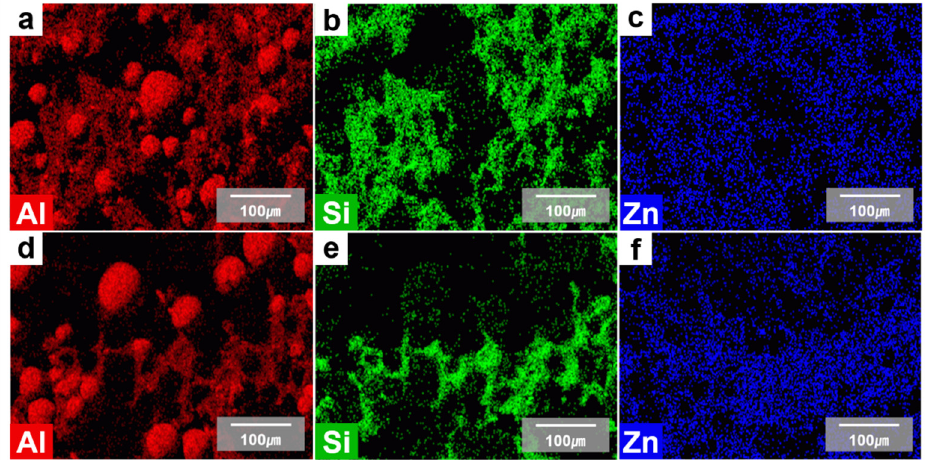
Figure 6. EDS mapping of thermal pads using aluminum oxide and zinc oxide powder of ( a – c ) type B-ZnO 10 and ( d – f ) type E-ZnO 10. Al, Si, and Zn are represented by red, green, and blue colors, respectively.